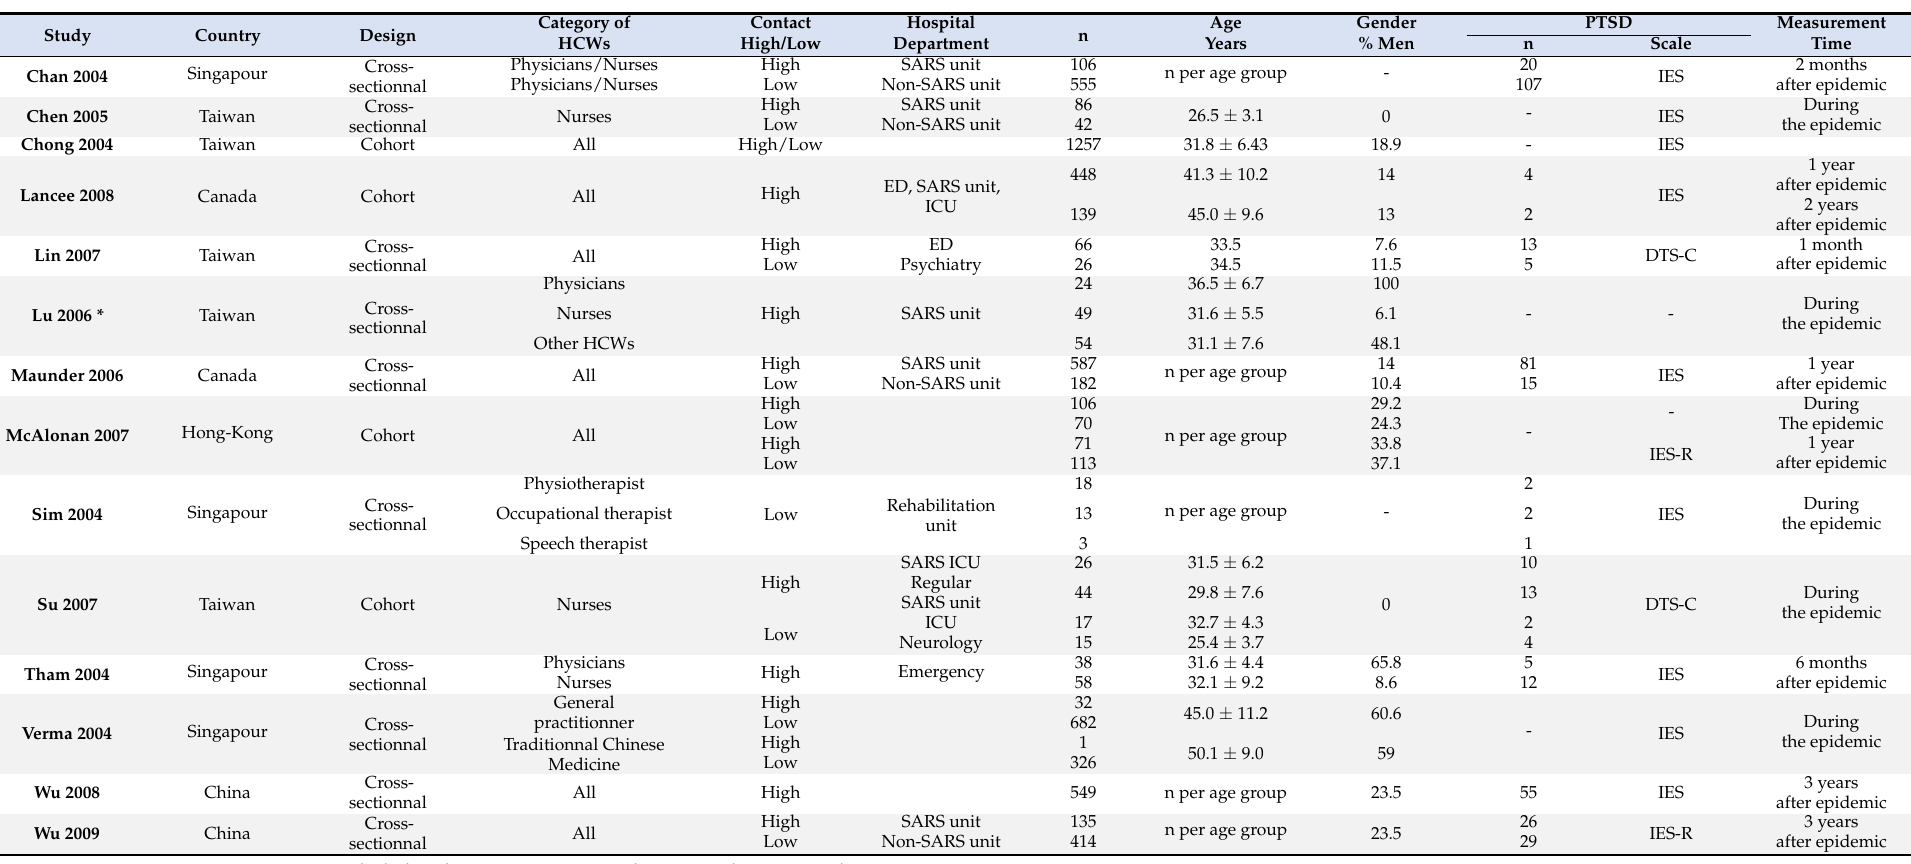
Table 1. Characteristics of included studies. DTS-C: Davidson Trauma Scale-Chinese version; ED: Emergency department; ICU: Intensive Care Unit; IES/IES-R: Impact Event Scale/Impact Event Scale Revised. Category